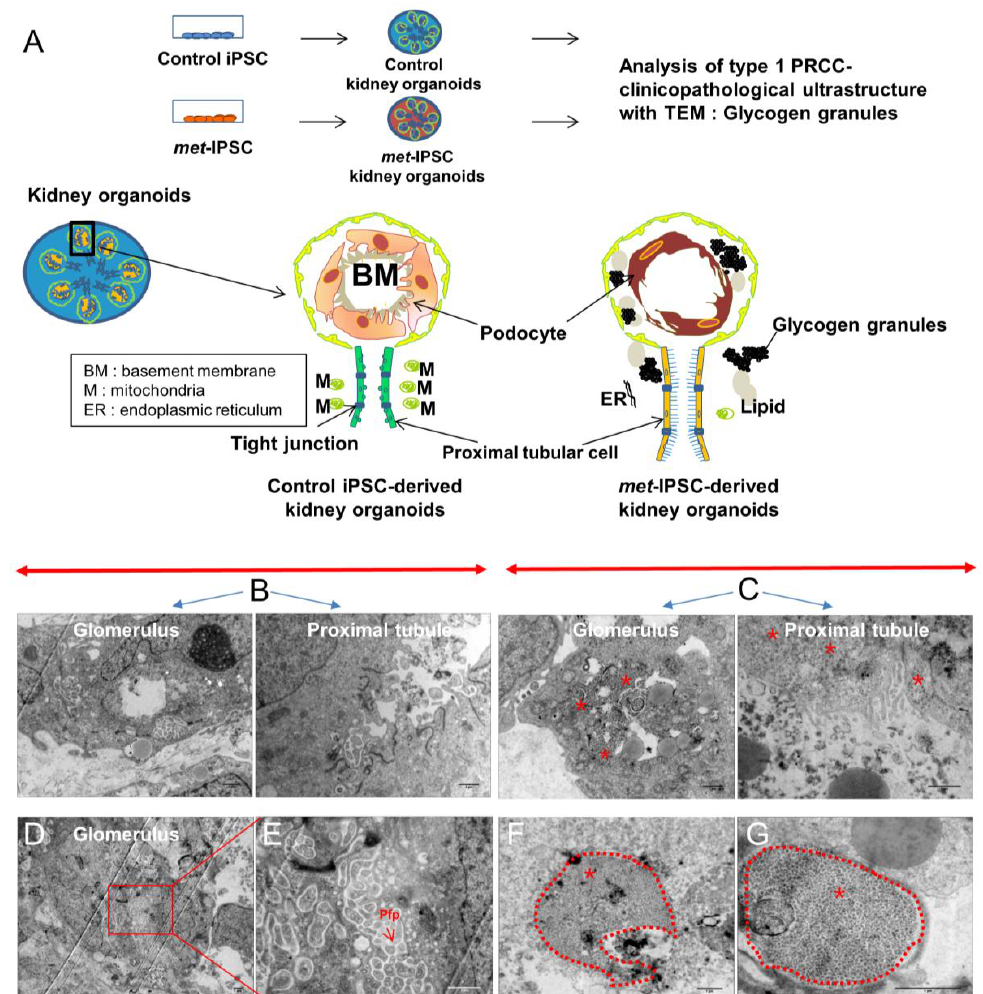
Figure 3. Ultrastructural analysis of kidney embryoid bodies derived from control or c- met -mutated iPSC. ( A ) Schematic representation of the experimental protocol used. ( B , C ) Representative electron microscopy images of glomerulus and tubules structures of control or c- met -mutated iPSC-derived kidney embryoid bodies. ( D , E ) Representative electron microscopy images cytoplasm region of control iPSC-derived kidney embryoid bodies. ( F , G ) Representative electron microscopy images cytoplasm region of c- met -mutated iPSC-derived kidney embryoid bodies, podocyte-like cells. Glycogen granules (*).